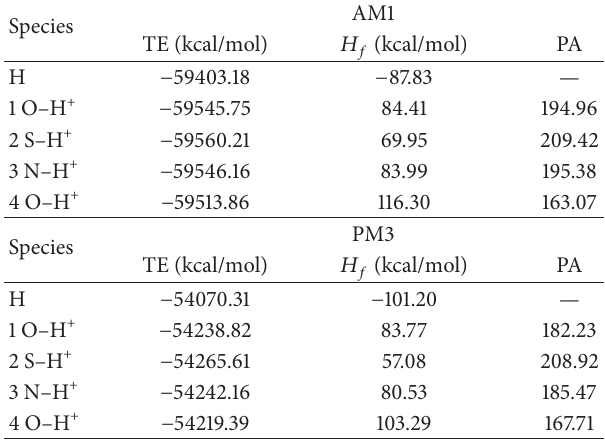
Table 2: The calculated 𝐻 𝑓 , TE and PA values with AM1 and PM3 methods for ligand and its monoprotonated